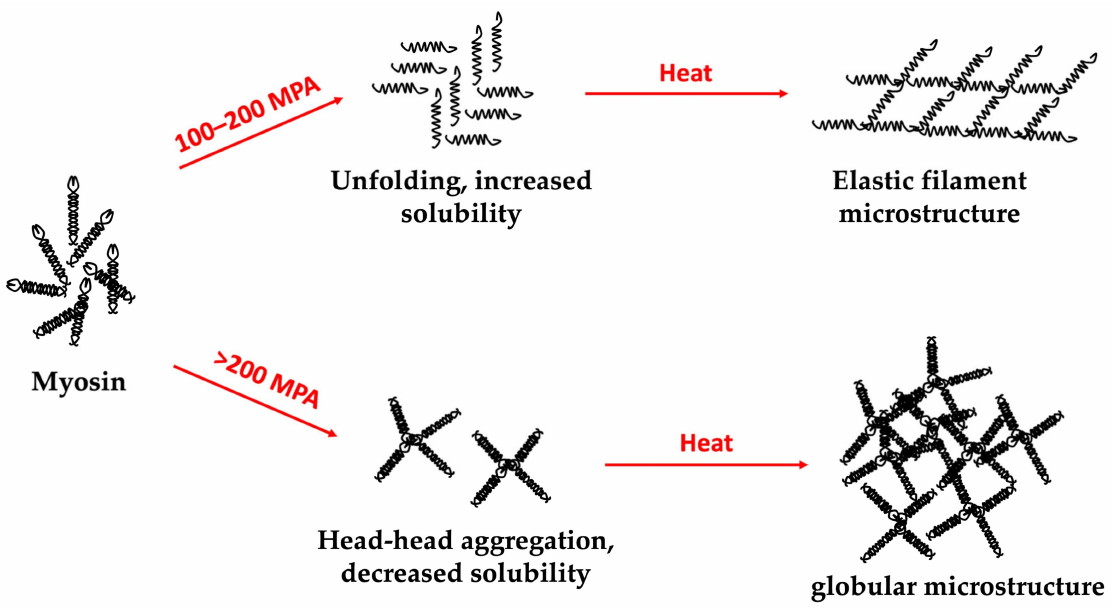
Figure 6. Schematic representation of HHP- and heat-induction effect on myosin hydrogel microstruc- ture